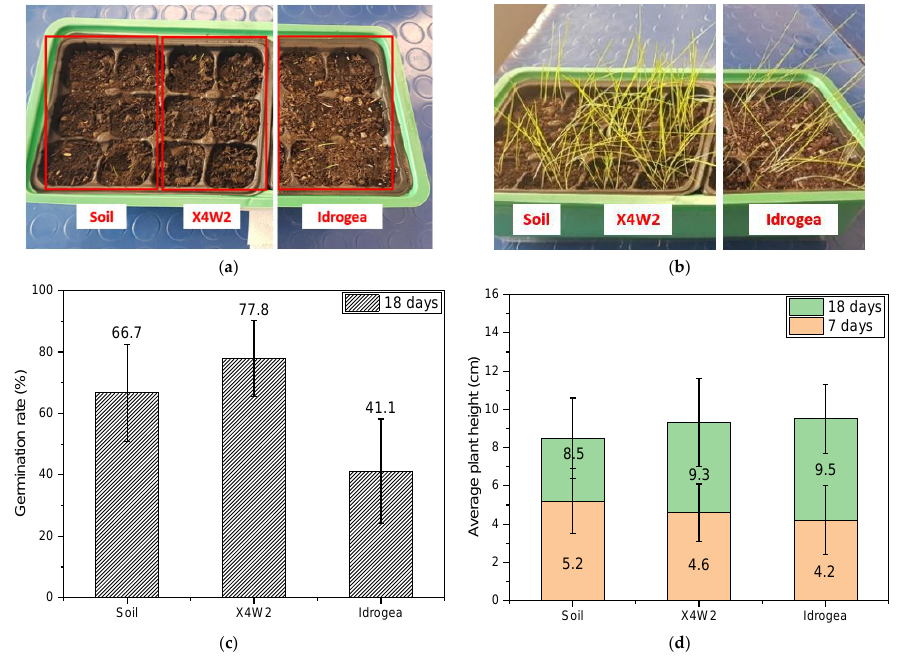
Figure 11. Representative images of ( a ) grass seeds planted in soil, soil treated with X4W2 and with the commercial product, ( b ) grass growth after 14 days. ( c ) Germination rate after 18 days and ( d ) average plant height over time.